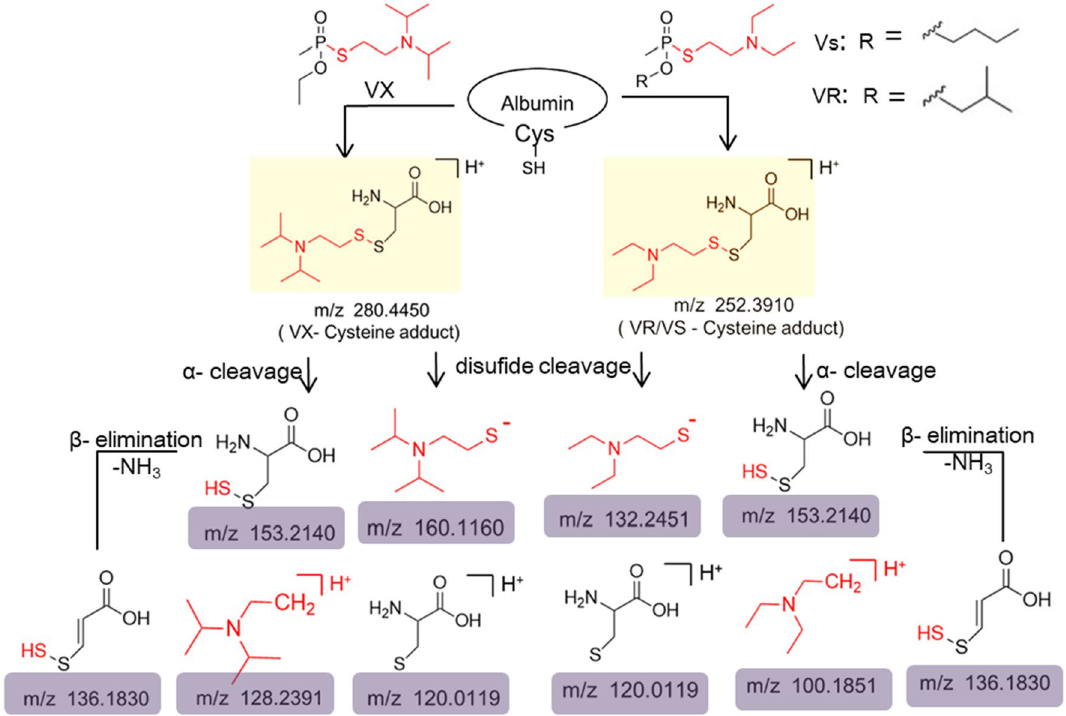
Figure 3. Characteristic ions of disulfide adducts after V-type OPNAs